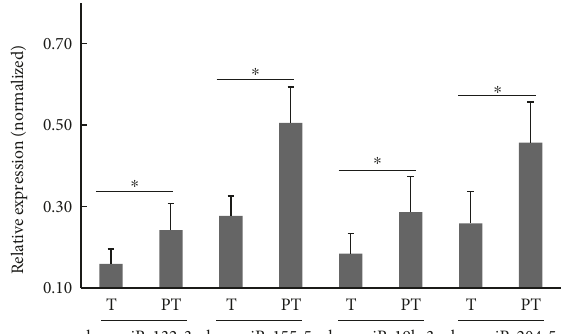
Figure 2: Stem-loop qRT-PCR con fi rmed the altered expression pattern of four miRs between tumoral (T) and peritumoral tissues (PT) in vivo. The relative miR expression levels were normalized by RNU6B. Data are expressed as mean ± SD, n = 6 . An asterisk ( ∗ ) indicates p < 0 05 .